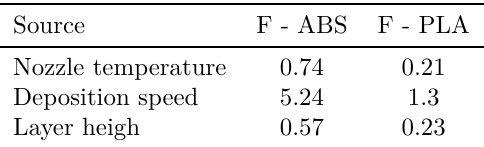
Table 4. Wettability F factors